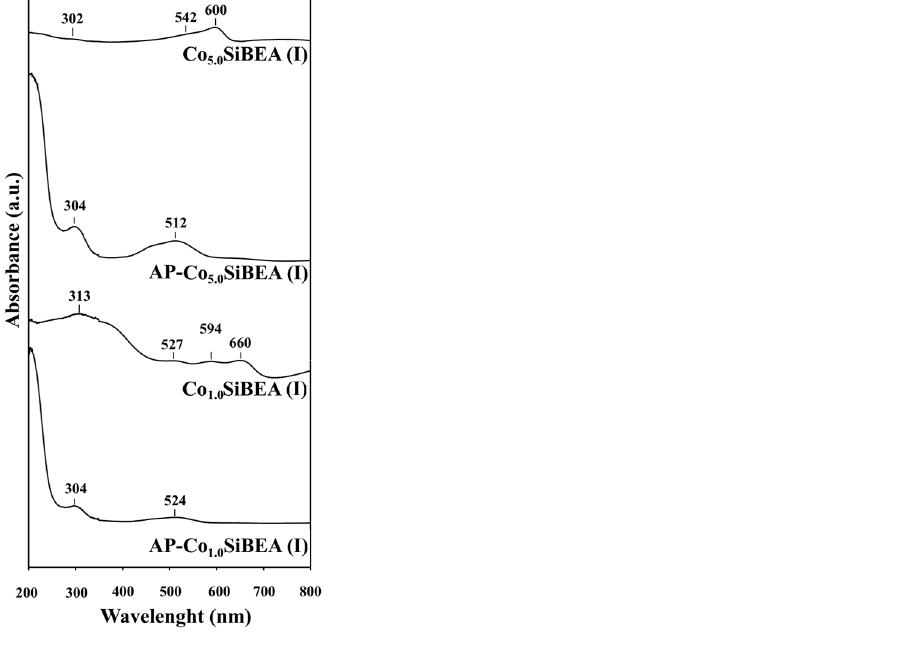
Figure 6. DR UV-vis spectra of selected samples of AP-Co x SiBEA(I) and Co x SiBEA(I) series recorded at room temperature and under ambient atmosphere.